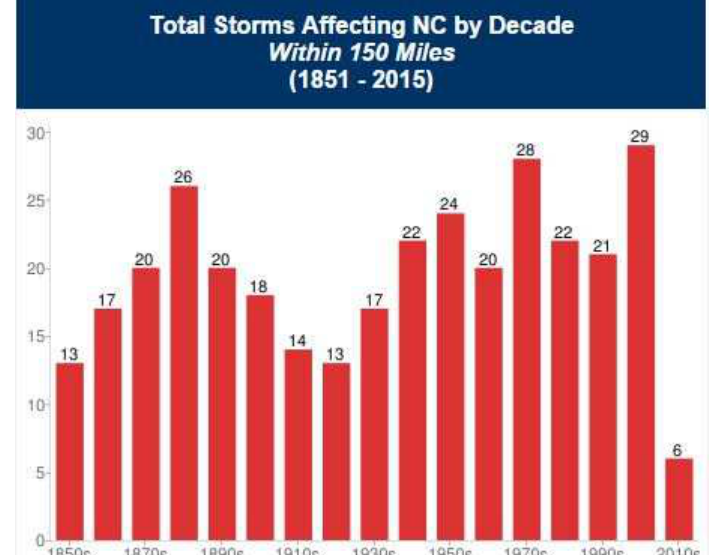
Figure 1. Total storms affecting North Carolina between 1851 and 2012